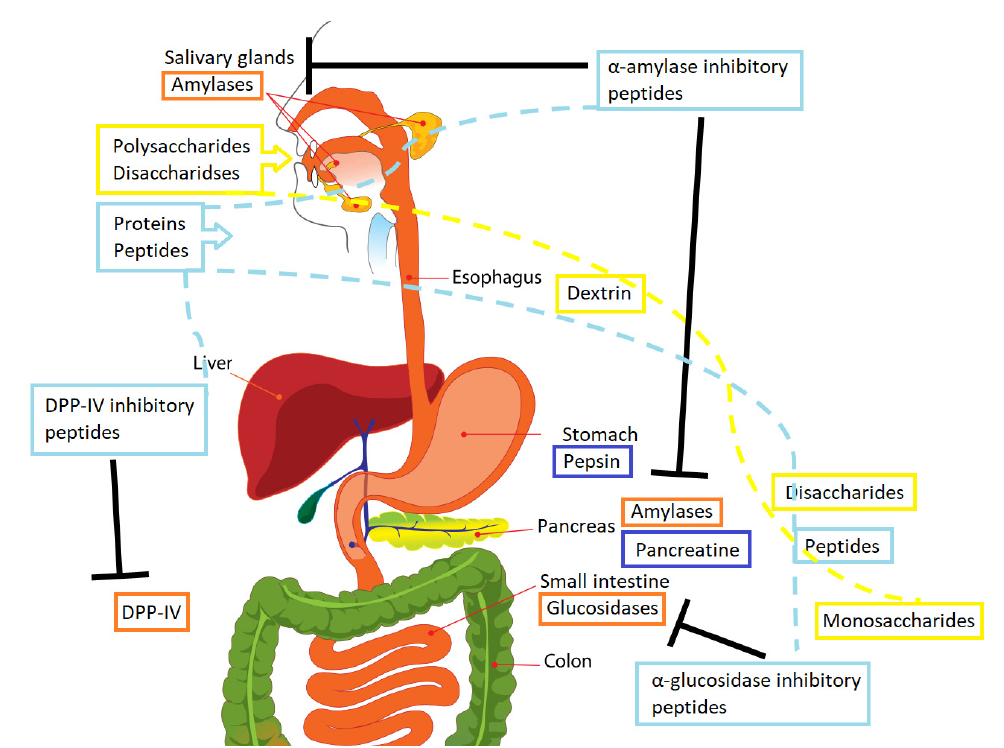
Figure 1. Mechanisms involved in peptides and carbohydrate digestion. The broken lines recreate the digestion process of the different molecules. Color reference: Yellow—Molecular state of carbohydrate during digestion; Orange—Main digestive enzymes involved in the carbohydrate digestion; Light blue—Molecular state of proteins during digestion; Dark blue—Digestive proteases. Permission: The original picture was released into the public domain by its author (LadyofHats) and modified by authors to depict the information detailed in the document.